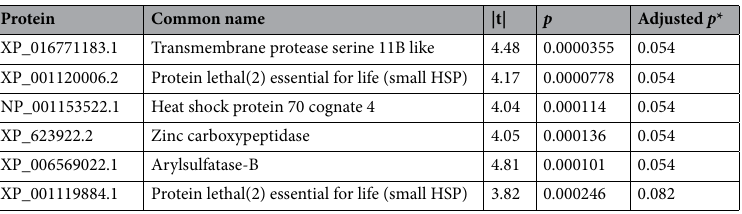
Table 3. Statistical summaries of proteins correlating with total viral loads. *Benjamini Hochberg